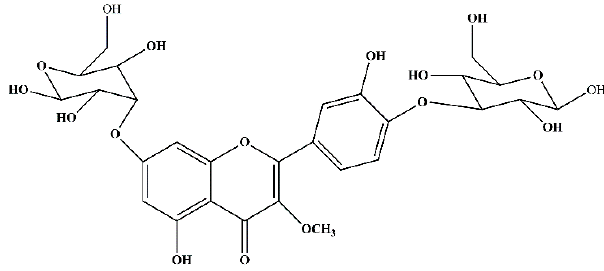
Figure 1. The structure of quercetin-3-methoxy-4 ′ -glucosyl-7-glucoside.